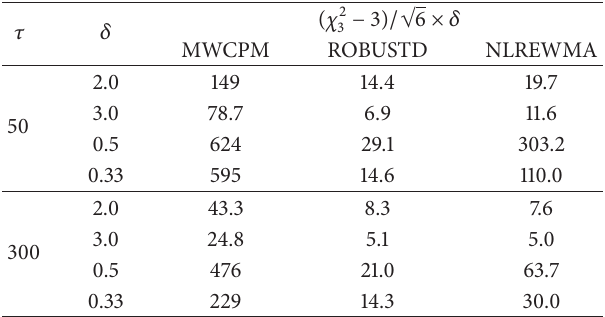
Table 4: ARL 1 (𝛿) for dispersion shifts in the skewed distribution 𝜒 2 3 , for several values of the change time 𝜏